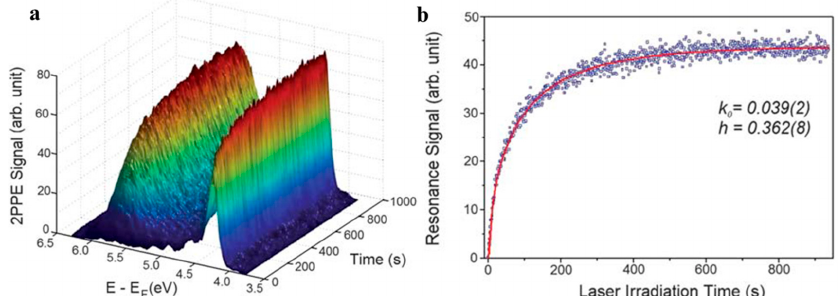
Figure 9. ( a ) Time-dependent two-photon photoemission spectra were measured for the freshly CH 3 OH adsorbed stoichiometric TiO 2 (110) surface after it had been exposed for different time durations. ( a ) This plot shows the evolution of the time-dependent two-photon photoemission spectra after the surface was exposed for certain time durations; ( b ) The time dependent signal of the excited resonance feature between 4.9 and 6.1 eV measured with the laser power of 64 mW. Reproduced with permission from [138]. Copyright RSC,